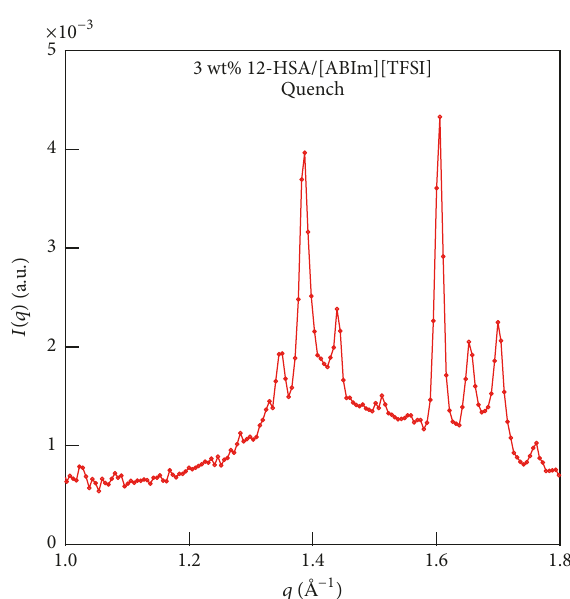
Figure 4: SAXS profiles of 3 wt% 12-HSA/[ABIm][TFSI] gel during the cooling process at a rate of 0.4 ∘ C/min. Profiles are vertically shifted for visual